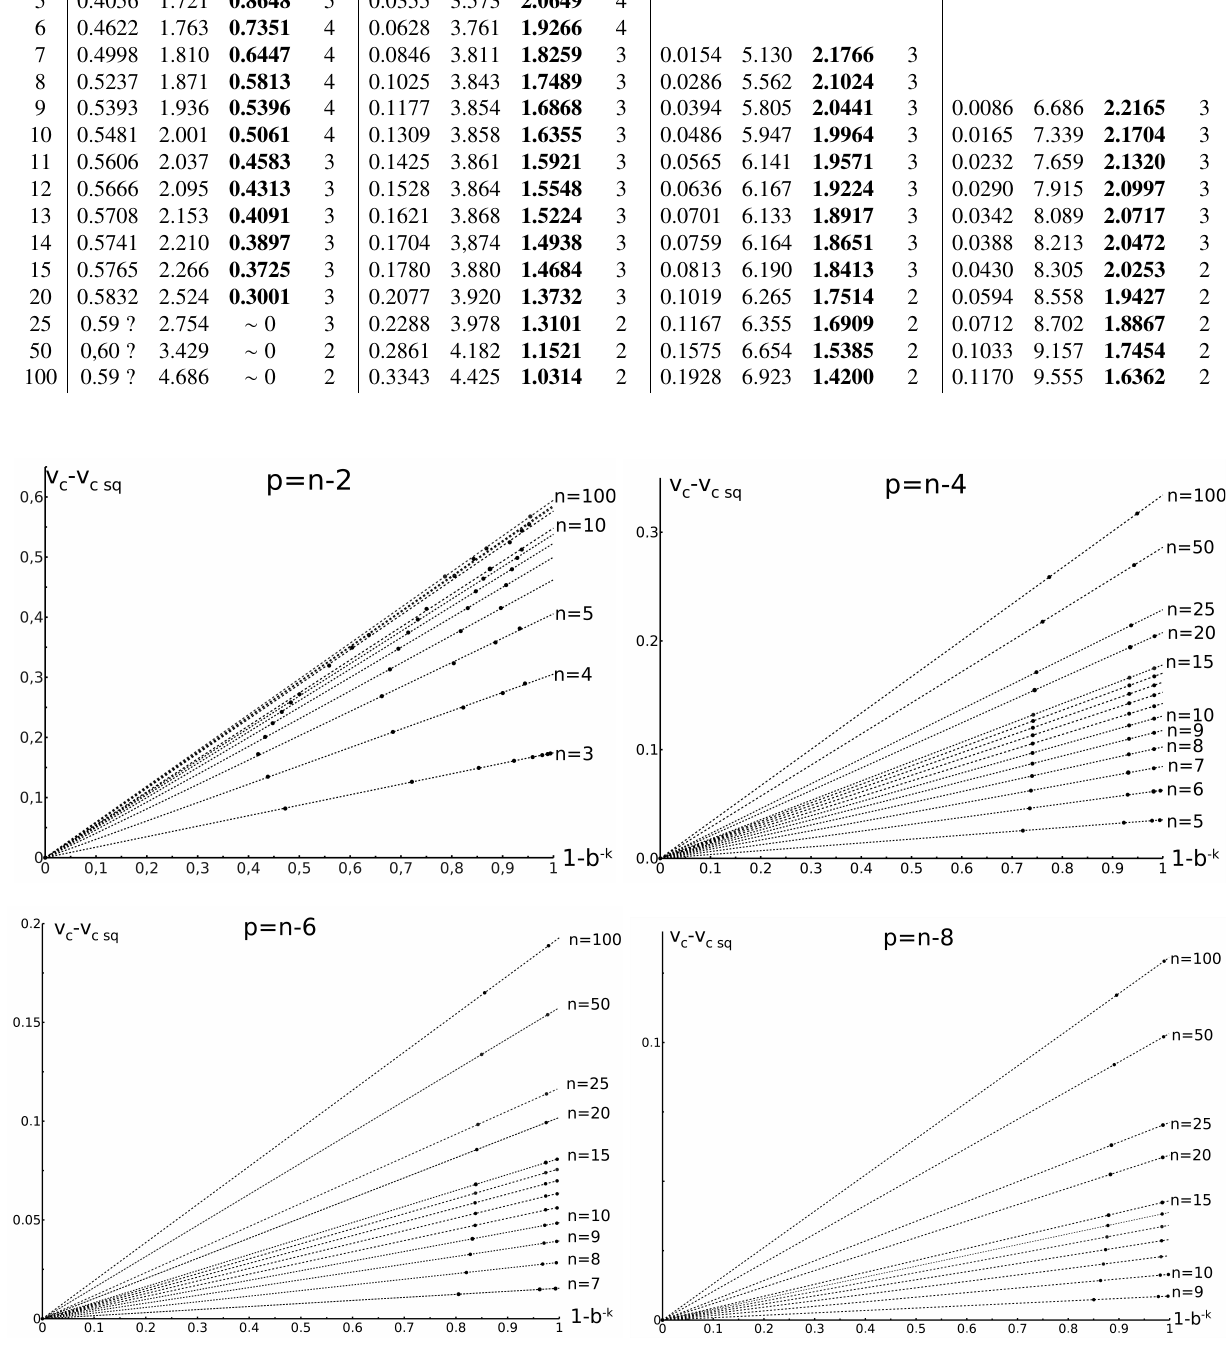
Figure 7. Plots of v c (cid:0) v csq versus (1 (cid:0) b (cid:0) k ) for Sierpiñski carpets corresponding to a wide range of values of n and p . All plots are linear after an appropriate choice of a and b